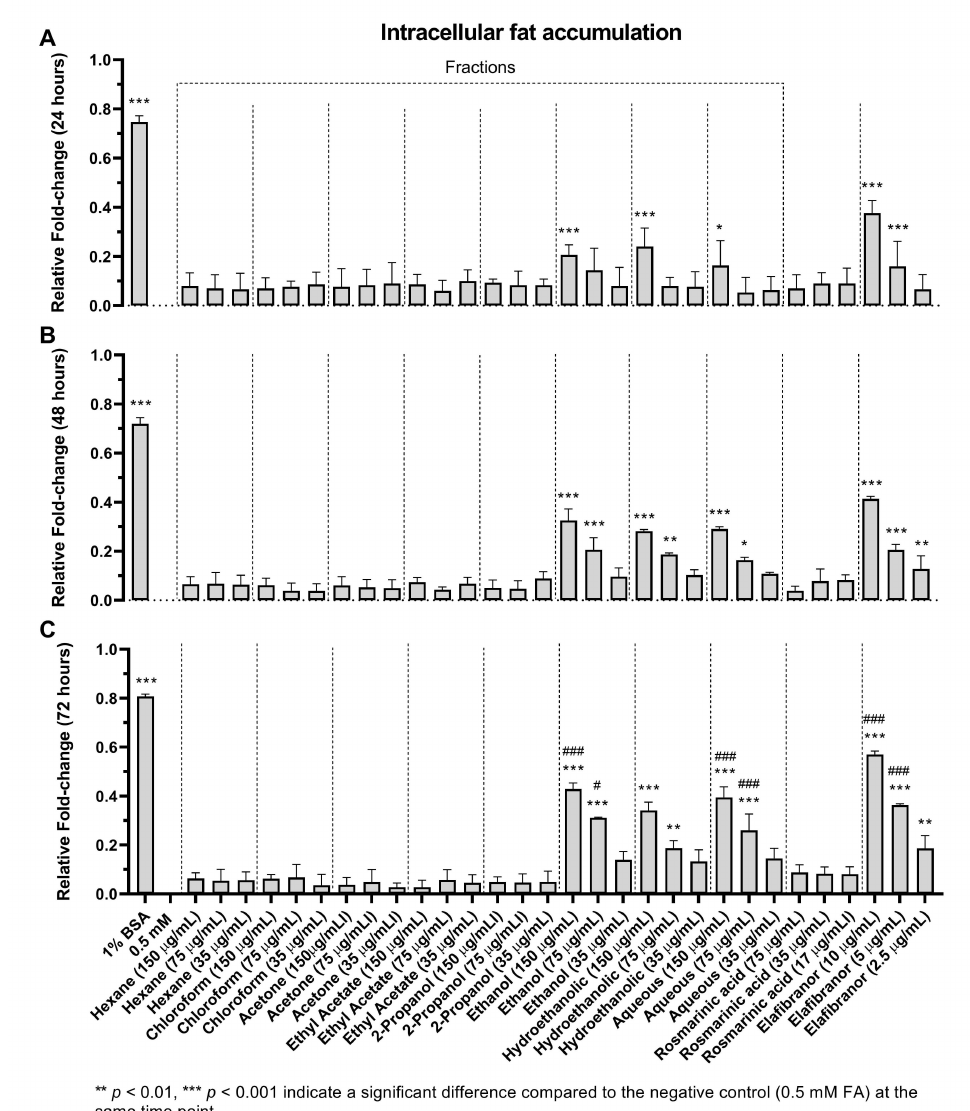
Figure 9. The effects of O. aristatus fractions on the intracellular fat accumulation. Fat accumulation level was tested after treating the steatotic cells with different concentrations of O. aristatus fractions at different time points (24 h ( A ), 48 h ( B ), and 72 h ( C )). The fat content was normalized per cell and then presented as fold change compared to 0.5 mM FA as a negative control. Values were presented as mean ± SD, n = 3, * p is